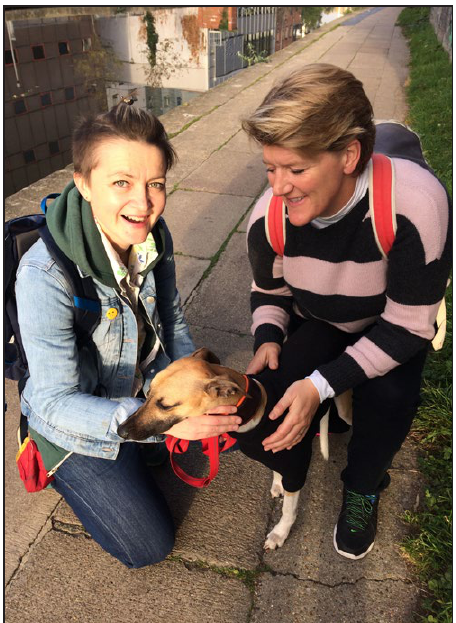
Figure 7 : The IoA’s Charlotte Frearson and Indy with Clare Balding (Photo: Charlotte Frearson/Lisa